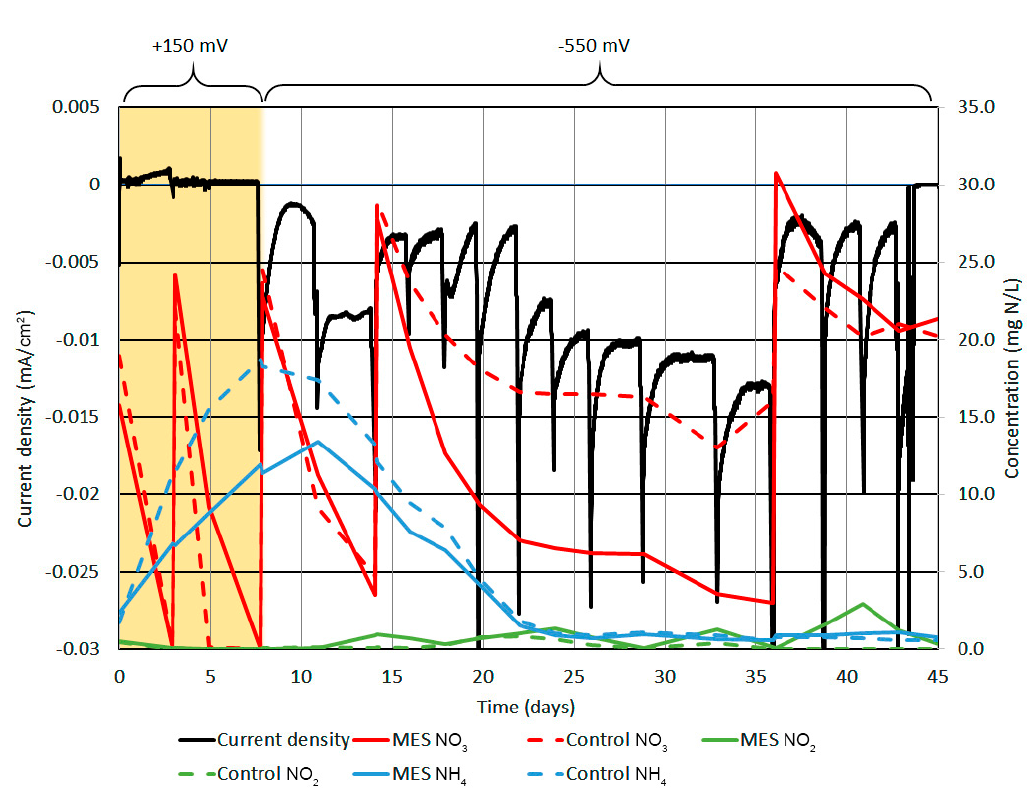
Figure 2. Current density, NO 3 − , NO 2 − , and NH 4 + concentration in cathode chamber. The black line shows current density, the red lines NO 3 − , the green lines NO 2 − and the blue lines NH 4 + concentration. Rapid increases in NO 3 − concentration on days 3, 7, 14, and 36 are related to KNO 3 addition. On days 0–7 (yellow background), the cathode polarization was posed at + 150 mV SCE. On day 8, it was switched to − 550mV vs. SCE.